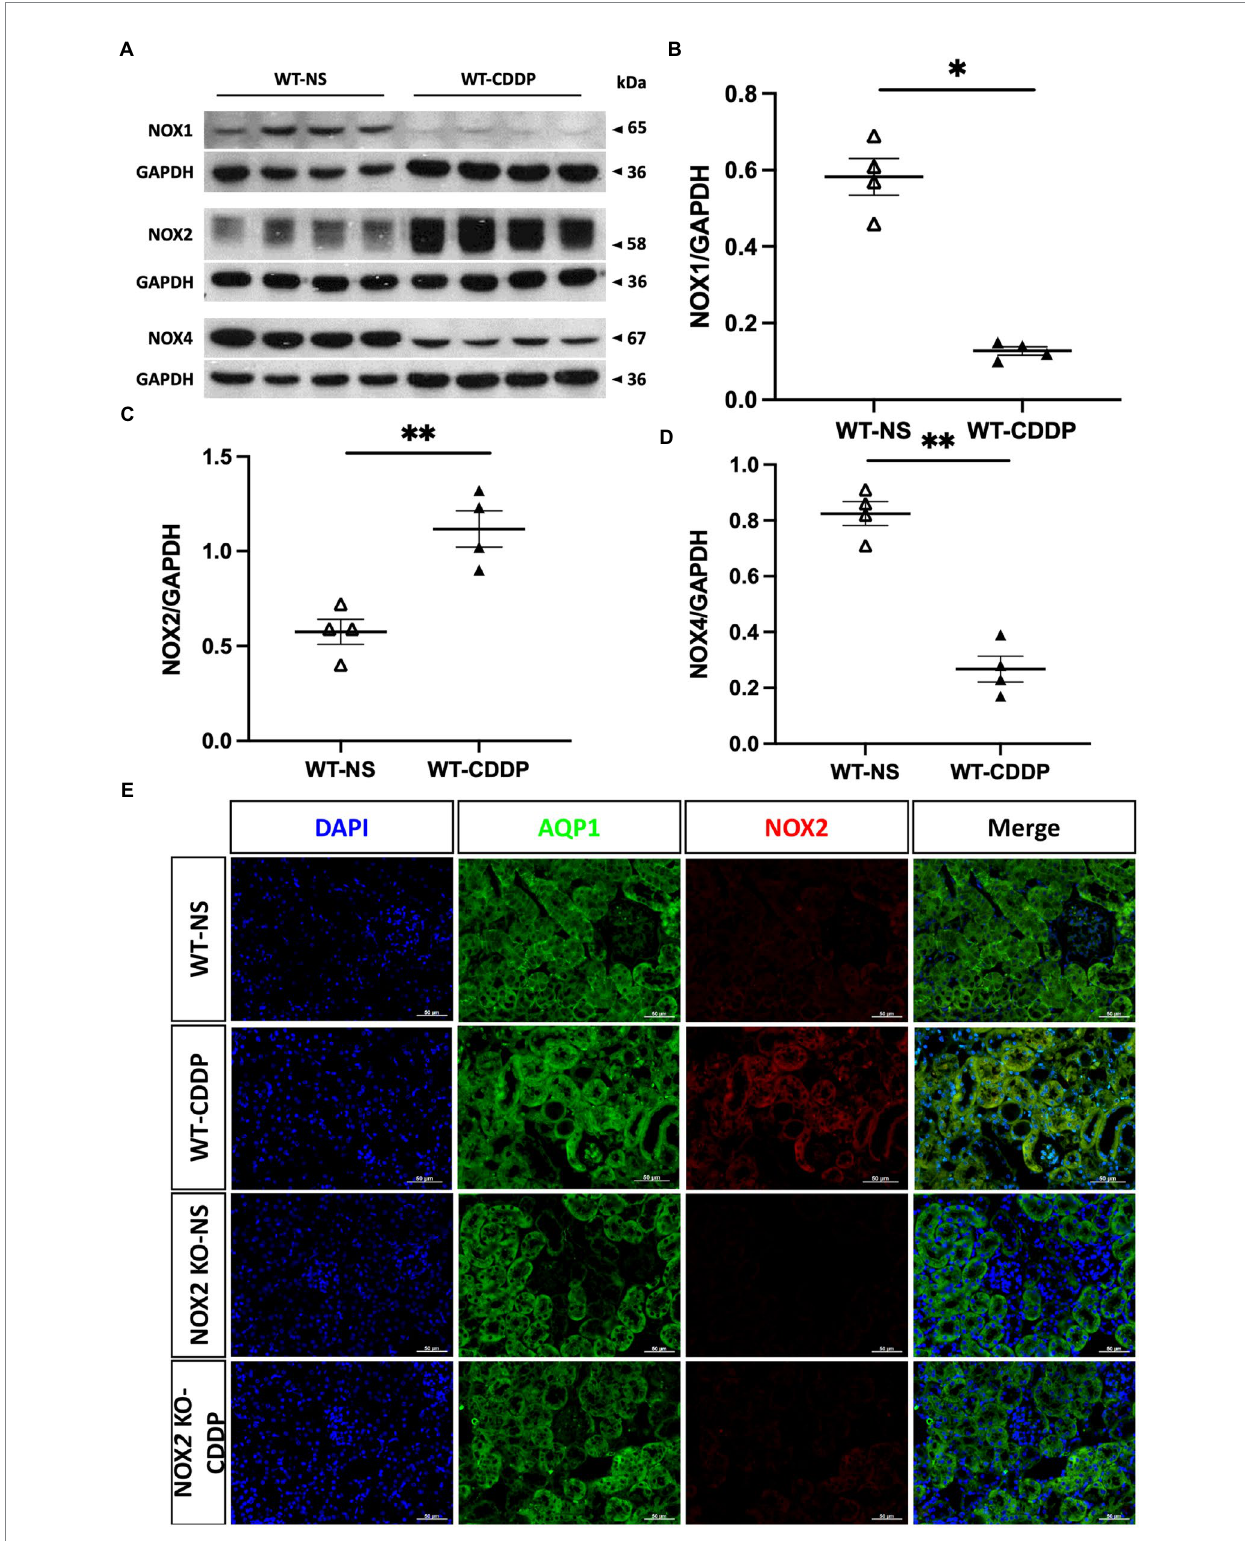
FIGURE 1 Increased NOX2 expression in cisplatin-induced AKI. Three days after cisplatin injection, western blot analysis was used to examine the main NOX family expression in cisplatin-induced AKI. (A) Western blots of NOX1, NOX2, and NOX4. (B–D) Quantitative analysis of NOX2 indicated overexpression compared to WT mice. However, NOX1 and NOX4 decreased after cisplatin injury. (E) Immunofluorescence staining suggests NOX2 expression in the epithelial cells along the renal proximal tubule in cisplatin-induced AKI. NOX2-KO mice did not show NOX2 expression in the normal saline and cisplatin groups. Data represent the mean ± standard error of four mice per group. Scale bar = 50 μ M. WT-NS, wild type-normal saline; WT-CDDP, wild type-cisplatin; AQP1: aquaporin